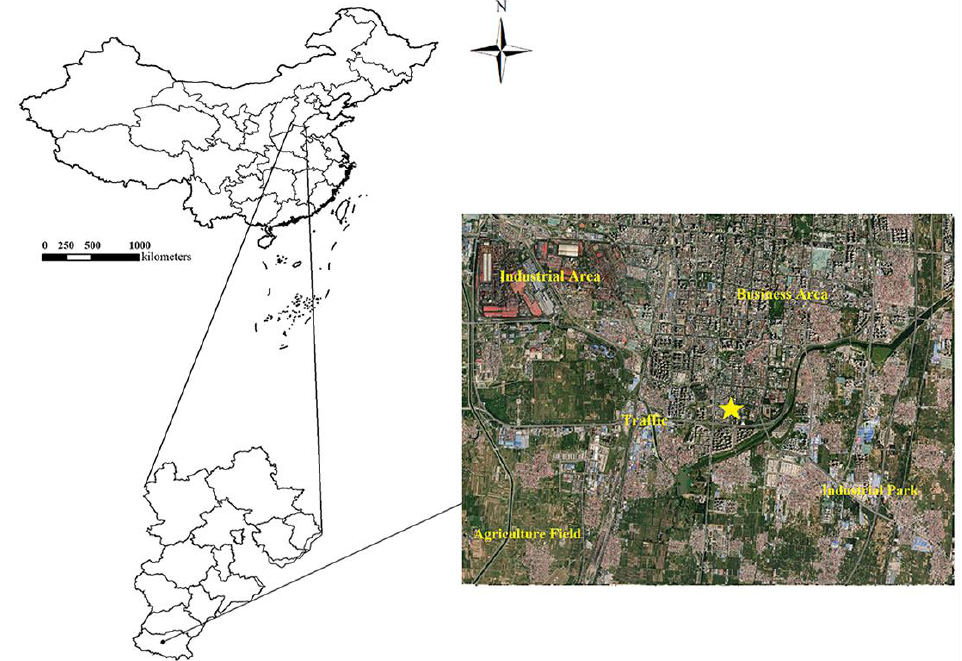
Figure 1. Map of sampling site in Handan city.